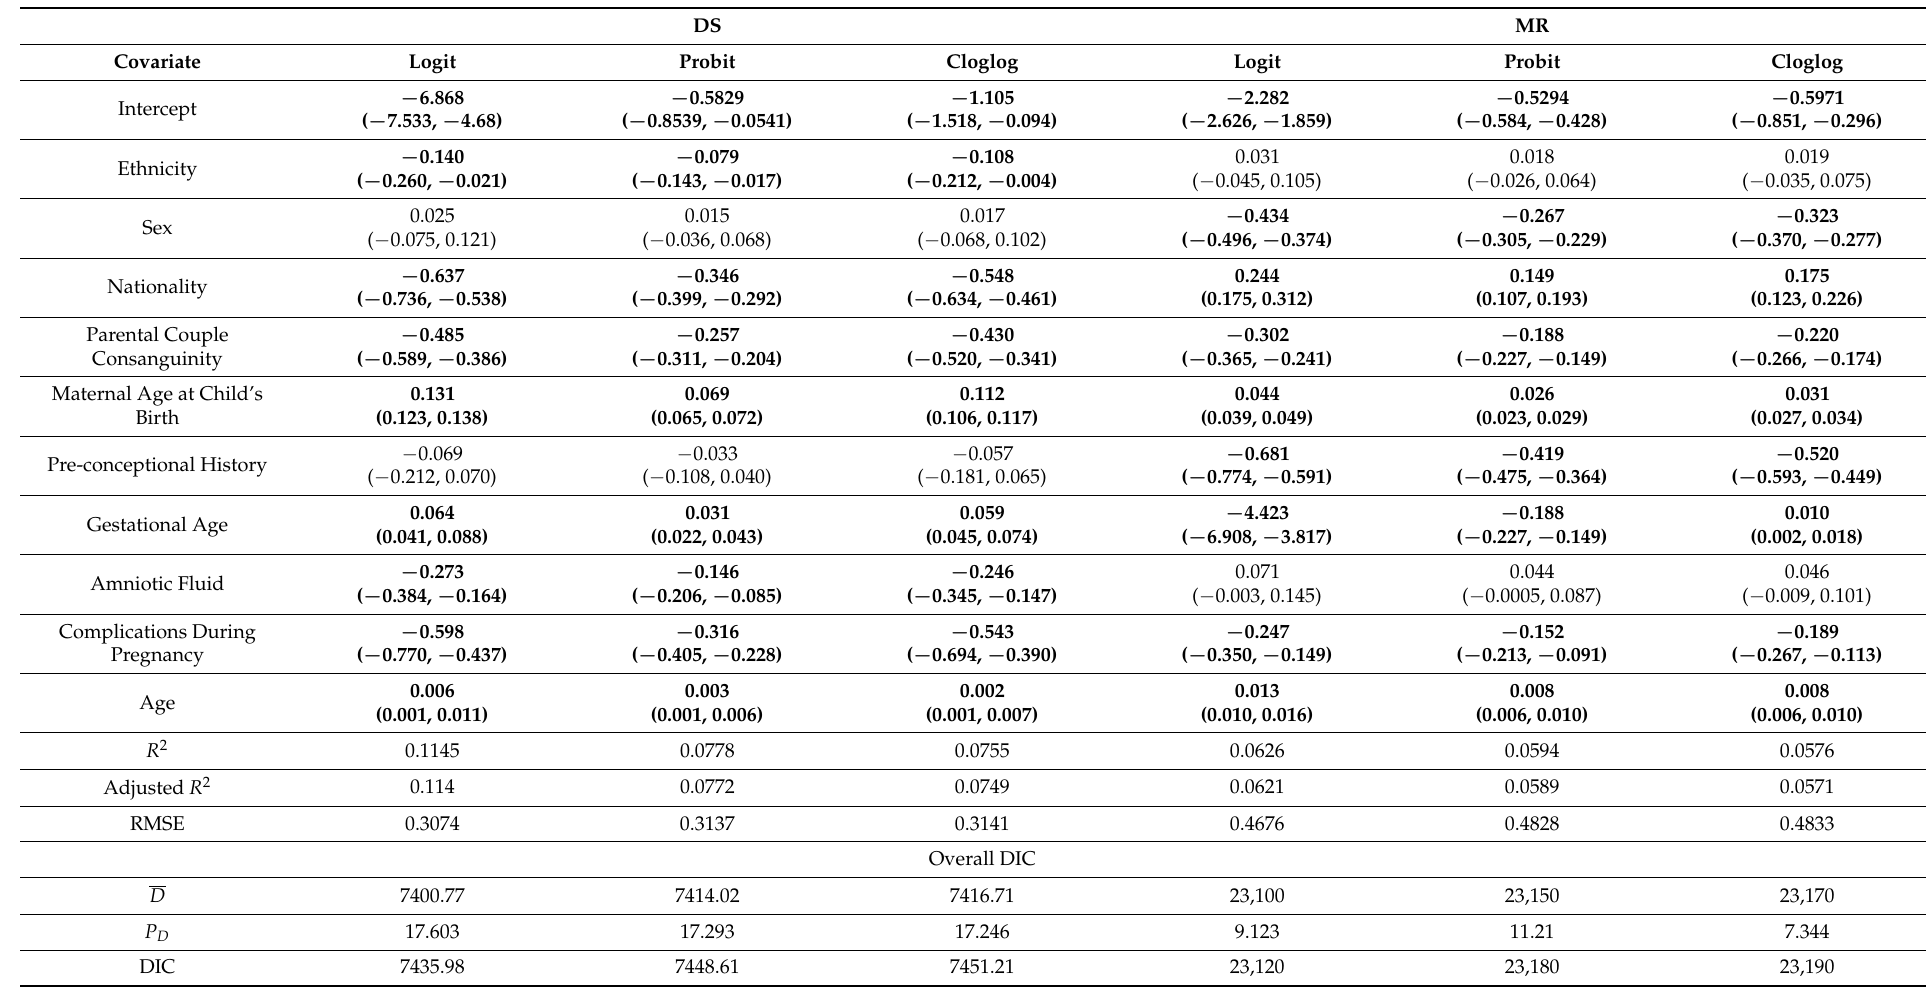
Table 1. Parameter estimates for the three models (95% credible interval in parentheses) for each of the Down syndrome (DS) and Mental retardation (MR) data. DS